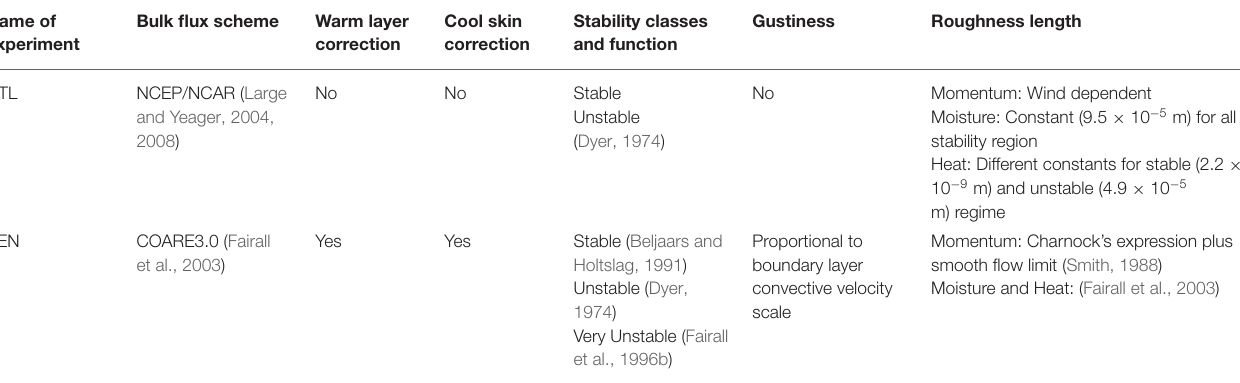
TABLE 2 | Description of difference between the bulk flux algorithms in CTL and SEN